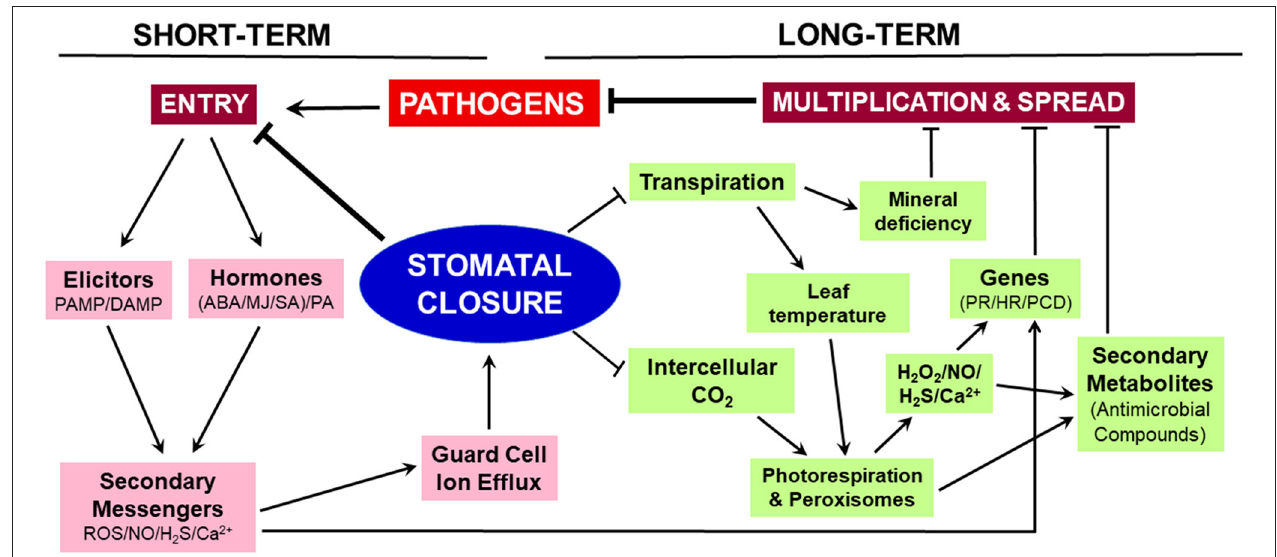
FIGURE 1 | Schematic representation of events associated with stomatal closure. The closure restricts microbial entry during the short term, while the events initiated during closure contribute to long-term adaptation against microbes. On sensing the microbial elicitor molecules, the guard cells trigger a rise in ROS, NO, Ca 2 + , and H 2 S. These secondary messengers cause ion-efflux from guard cells and stomatal closure. As a consequence of closure, the entry of CO 2 and transpirational H 2 O loss are restricted, leading to increased photorespiration, decreased leaf sugars, and mineral deficiency. All these events help in restricting microbial multiplication, spread, and growth. The disturbed hormonal status and reactive molecules ensure continued protection by upregulating PR/HR/PCD genes and promoting the levels of antimicrobial secondary metabolites. Arrow represents an increase and ⊣ indicates a decrease.